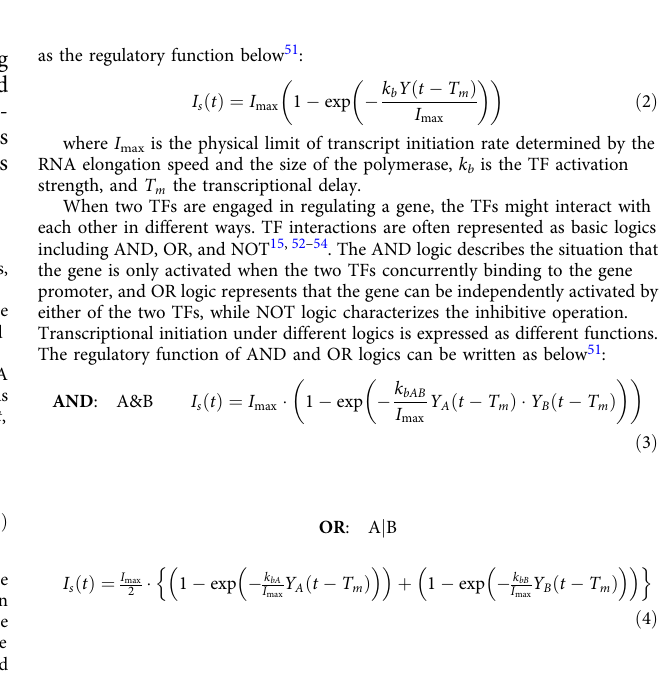
Fig. 6 The TRNs of hiPSC-derived CM differentiation. Time-course gene expression microarray data was employed. The data represents 0, 3, 7, 10, 14, 20, 28, 35, 45, 60, 90, and 120 days following the hiPSC-derived CM differentiation, which was divided into four stages, T1 (0 – 3 days), T2 (7 – 20 days), T3 (28 – 45 days), and T4 (60-120 days). For a (at T1-T2 stage) and b (at T2-T3 stage), triangle nodes in blue refer to TFs, and triangle nodes in light blue are TF logics. The target genes in different pathways of logics are represented in oval nodes (contraction), diamond nodes (stem cell pluripotency), hexagon nodes (Ca handling), and rectangle nodes (heart development). Nodes in red and green represent upregulated and downregulated genes, respectively. Logic relationships include AND (&), NOT ( ¬ ), and OR ( |